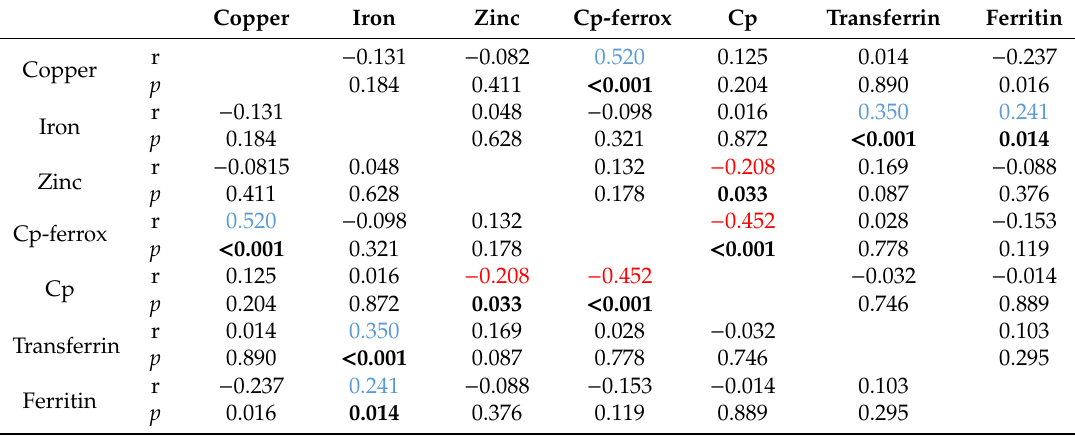
Table 5. Partial correlation between baseline metal and metal metabolism markers adjusted for BMI and sex. p < 0.05 are shown in bold with positive associations (r > 0) shown in blue, and negative associations (r < 0) shown in